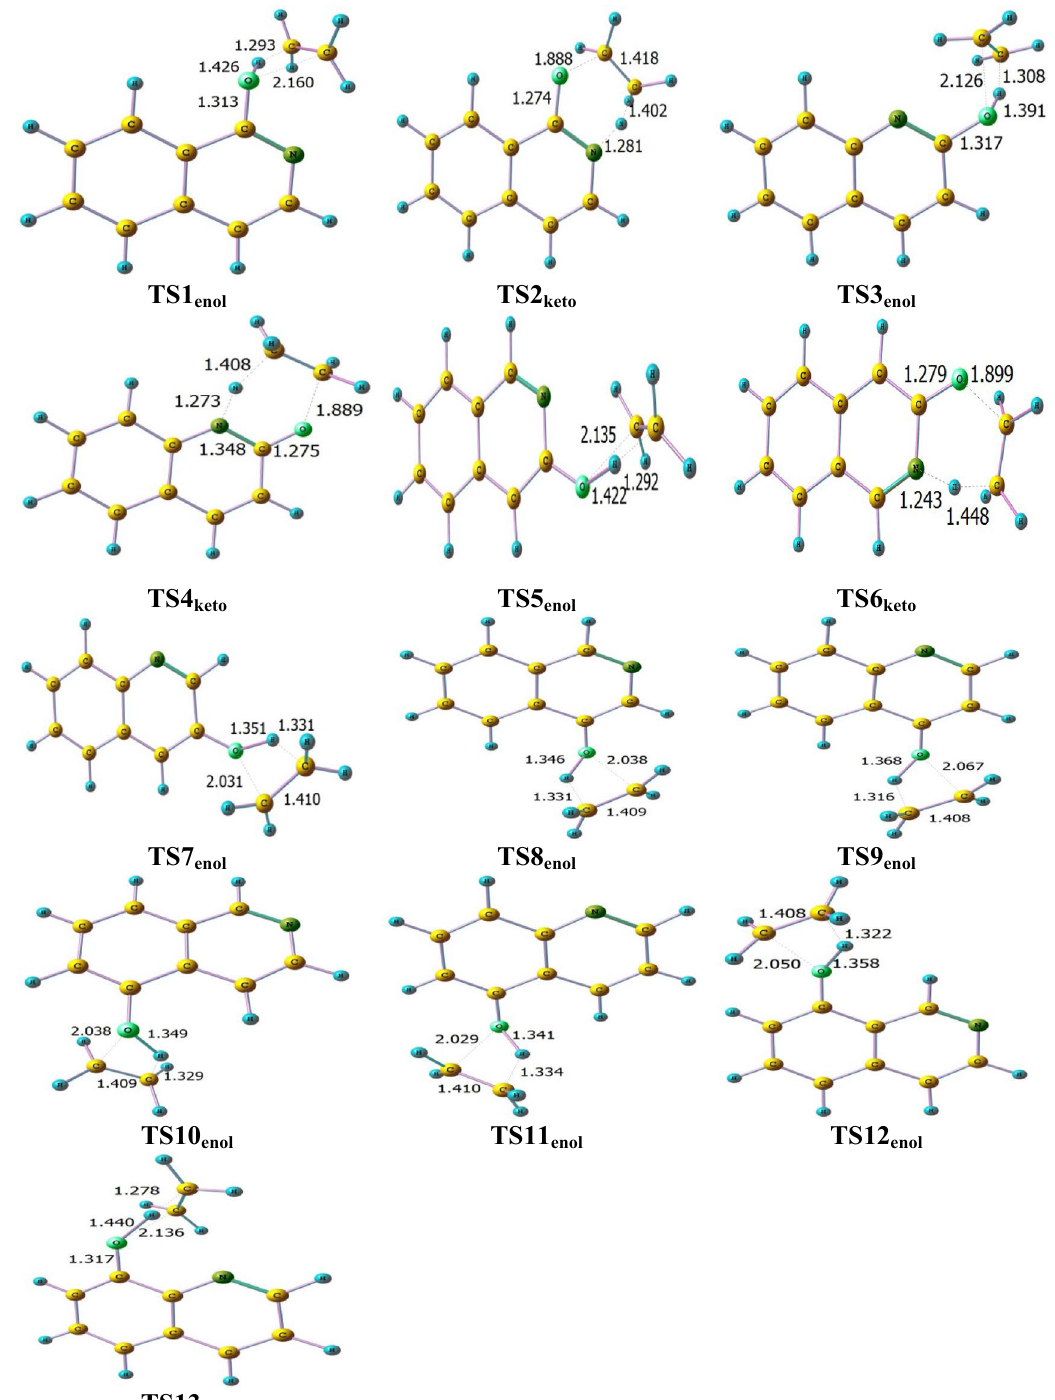
Figure 4. Optimized transition state structures for the thermal decomposition reactions of ethoxyisoquinolines, ethoxyquinolines calculated at BMK/6–31+G(d,p) level. Bond lengths and angles are given in Ångström and degree,